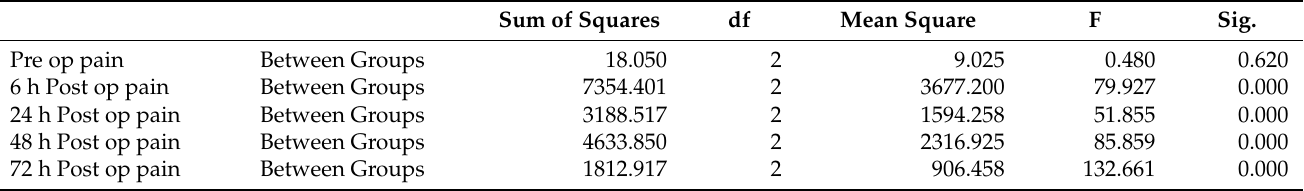
Table 3. Intergroup post-instrumentation comparison between three groups at different time interval. Sum of